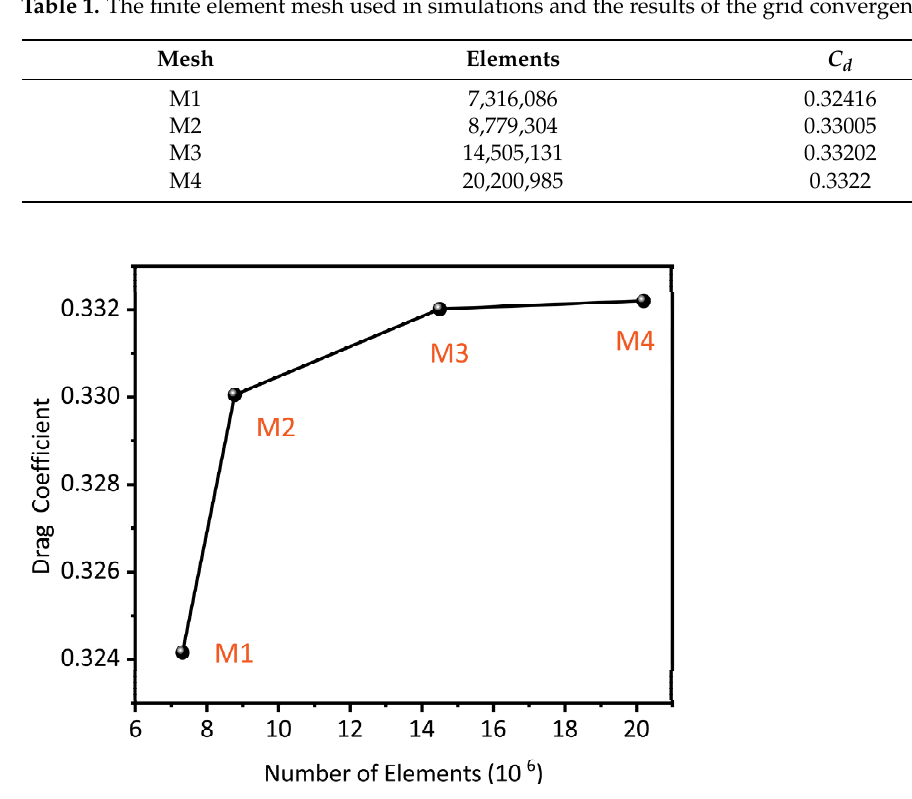
Figure 5. Grid convergence study for 𝐶 (cid:3031) with respect to the number of elements in the computa- tional